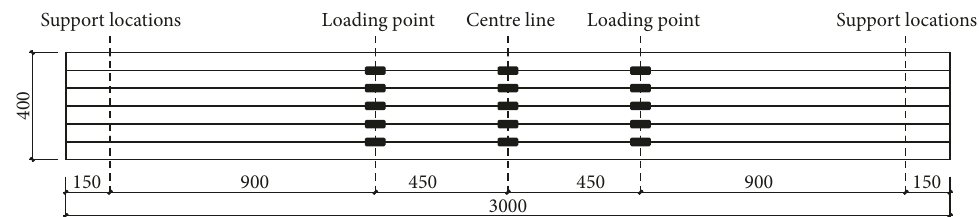
Figure 12: Strain gauge layout of screw-thread steels and CFRP bars (mm).